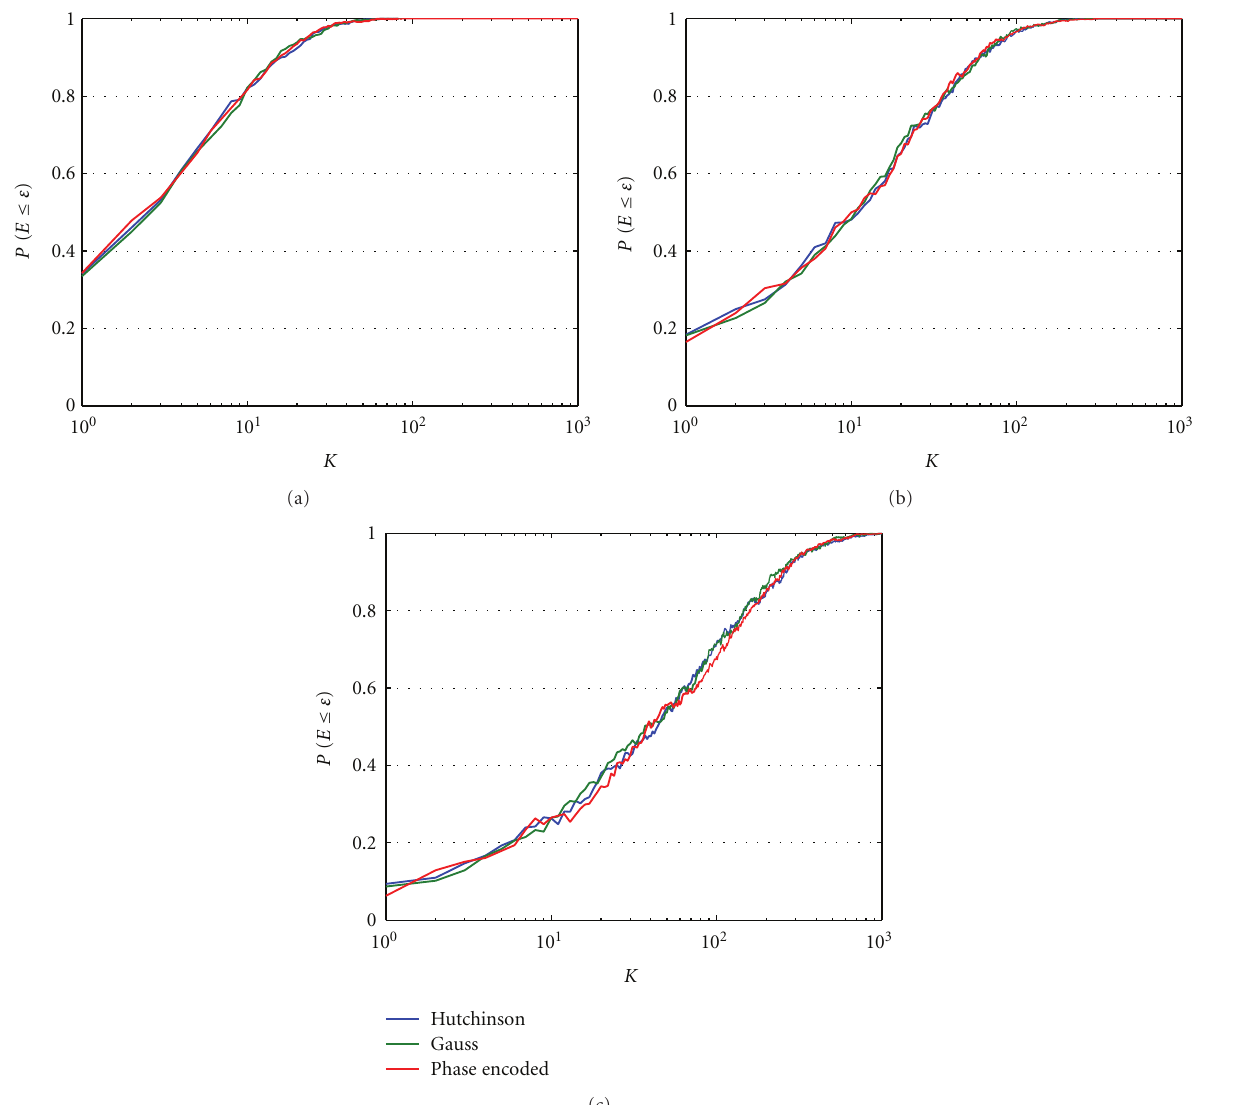
Figure 6: Reconstruction as a function of K for various methods and error levels: (a) (cid:2) = 10 − 1 , (b) (cid:2) = 10 − 2 , and (c) (cid:2) = 10 − 3